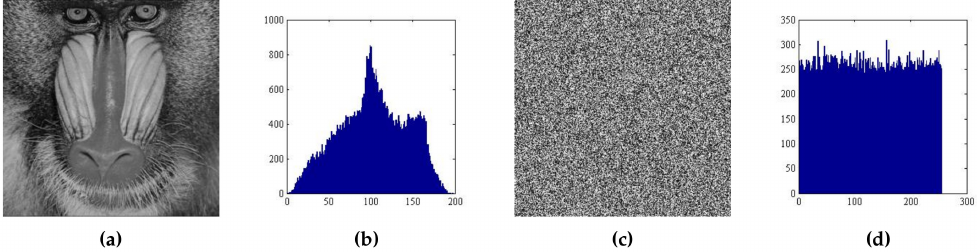
Figure 11. Result of Baboon image. ( a ) Baboon image, ( b ) histogram of Baboon image, ( c ) encrypted Baboon, and ( d ) histogram of encrypted Baboon.